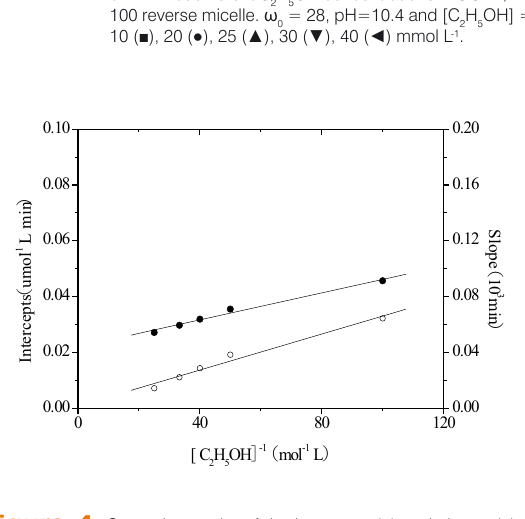
H OH concentrations in GGDE/TX- 2 5 = 28, pH=10.4 and [C 0